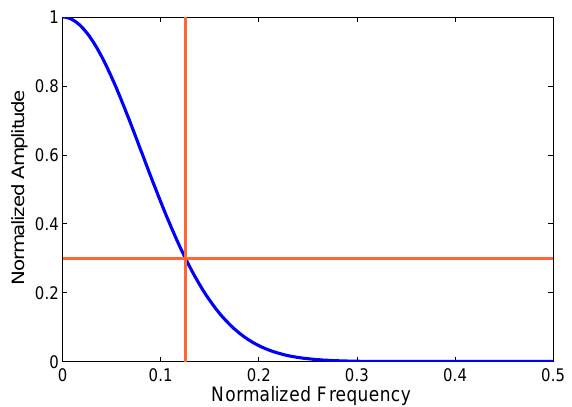
Figure 7. Frequency response of a Gaussian-like MTF filter in the case of M = 4 and K min = 0.3.